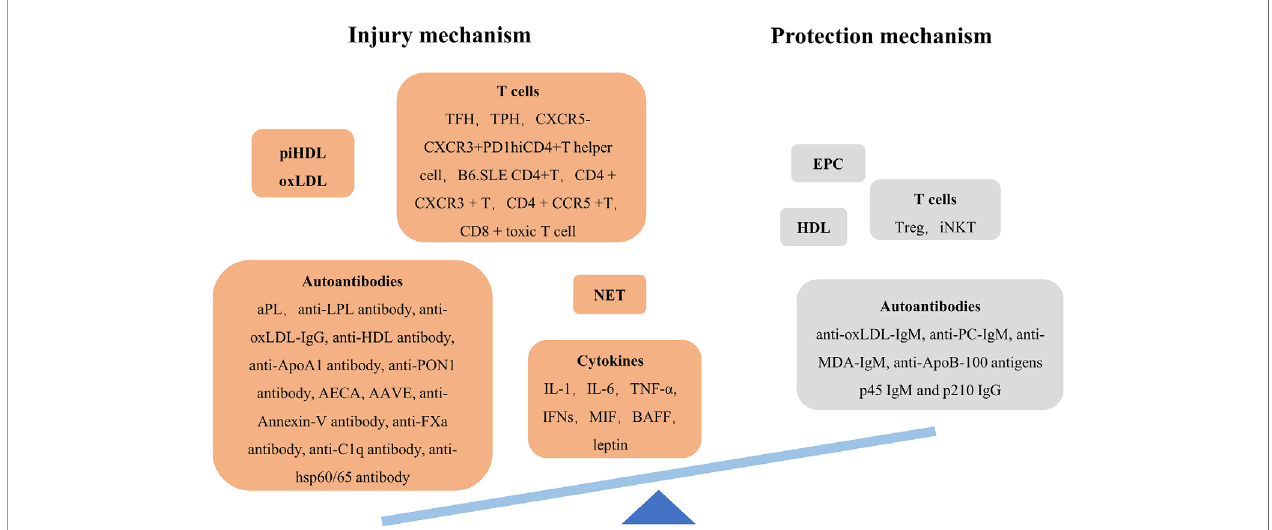
FIGURE 1 | Imbalance of injury/protection mechanism of SLE arteriosclerosis. AAVE anti-vascular endothelial-cadherin antibody AECA anti-endothelial cell antibody aPL antiphospholipid antibody BAFF B cell-activating factor EPC endothelial progenitor cell iNKT invariant natural killer T cell LPL lipoprotein lipase MDA malondialdehyde; MIF, macrophage migration inhibitory factor; NET, neutrophil extracellular trap; PC, choline phosphate; TFH, follicular helper T cell; TPF, peripheral helper T